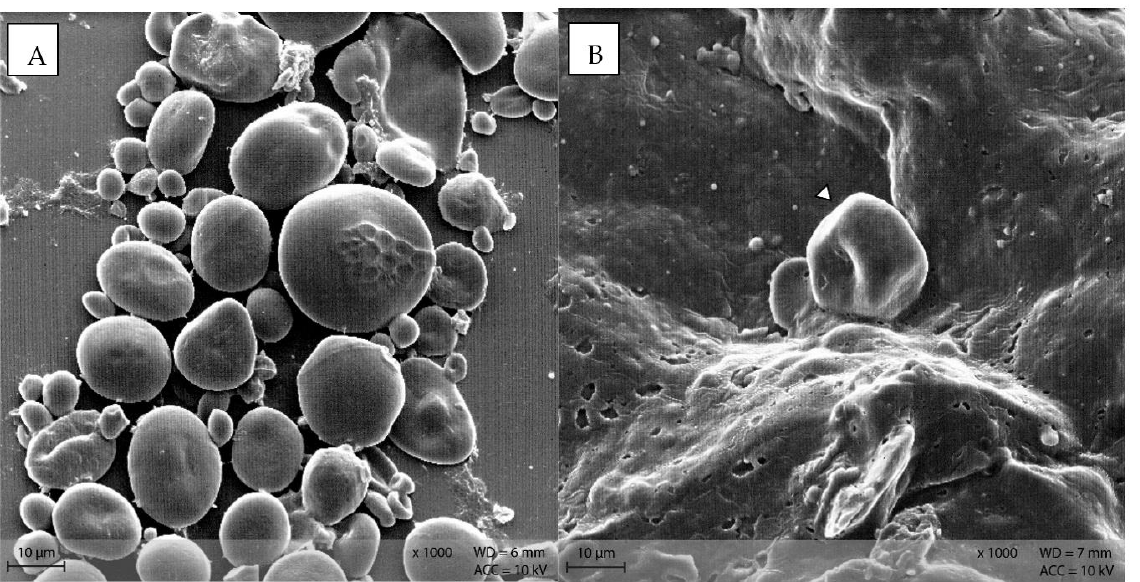
Figure 9. Starch granules in the diets ( A ) PEL as round, compact granules of different size, and ( B ) EXT as irregularly shaped particle (Scanning electron microscopy; ∆ marking irregularly shaped starch particles in B).